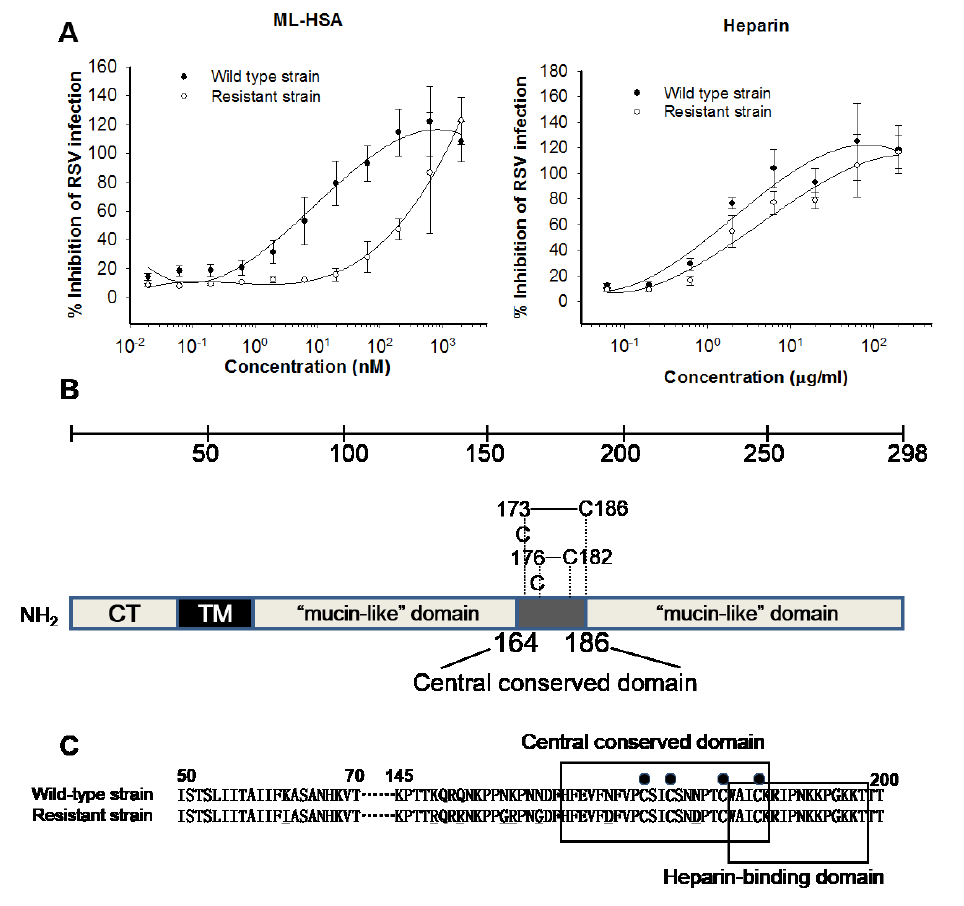
sequences of the G proteins of the wild-type strain (parent strain) and ML-HSA resistant strain were compared. We observed 8 amino acid mutations (K62I, K149R, Q152R, N157G, K158R, N161G, N169D, and N179D) in the G protein of the resistant strain, 7 of which were located in the region overlapping the residues 145–186, including the conserved domain (residues 164–186). These data suggest that ML-HSA may bind to the middle portion of the RSV G protein.